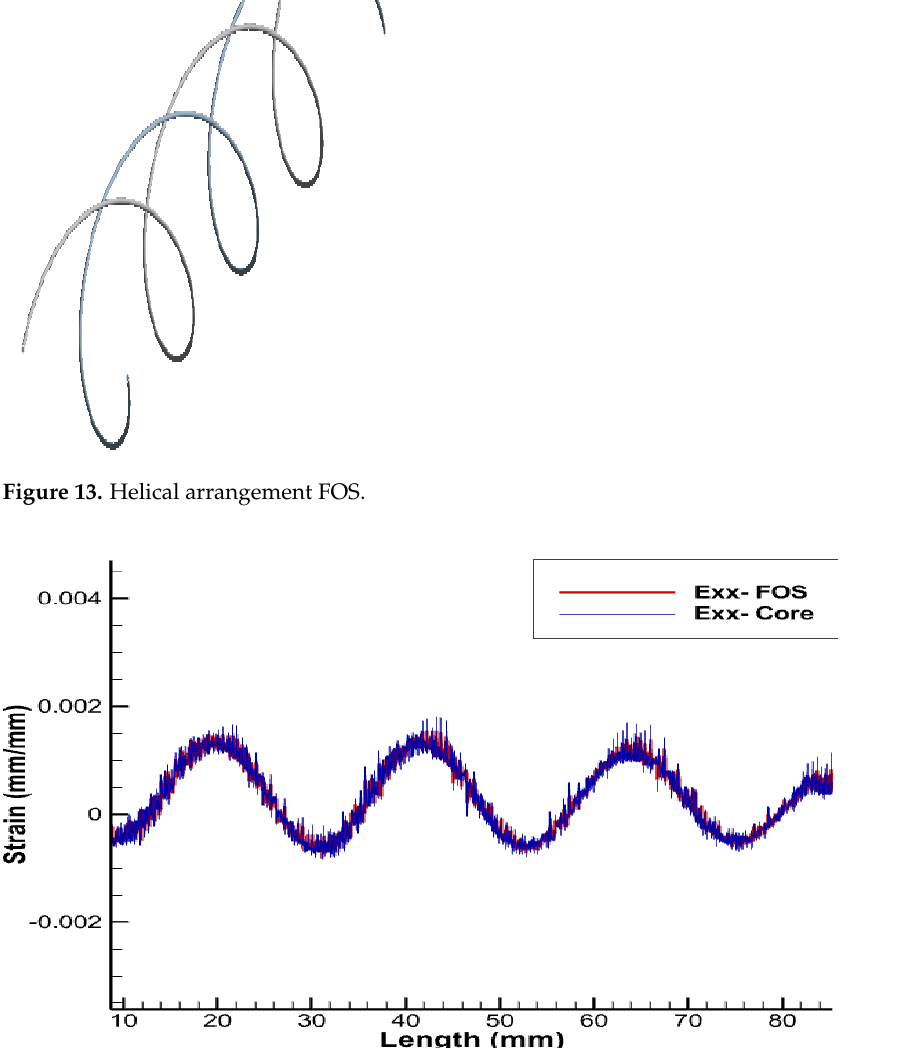
Figure 14. E xx strain for helical arrangement of FOS.